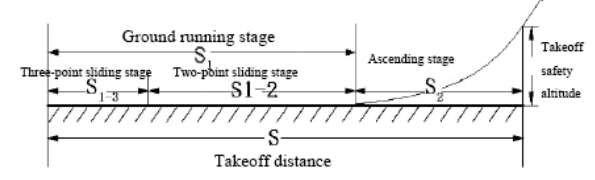
Figure 4. Schematic diagram of the take-off stage.